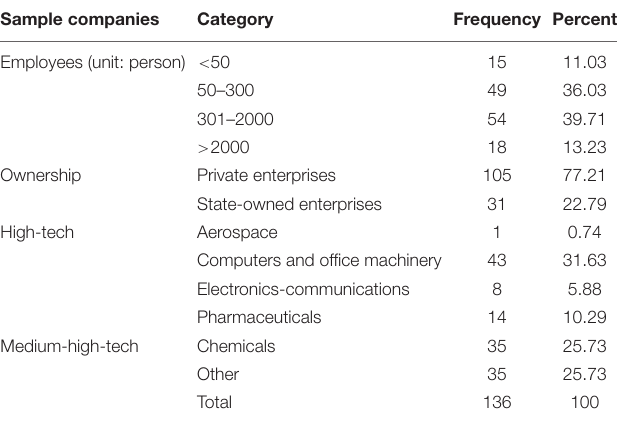
TABLE 1 | Descriptive statistics of the sample companies ( N = 136). Sample companies